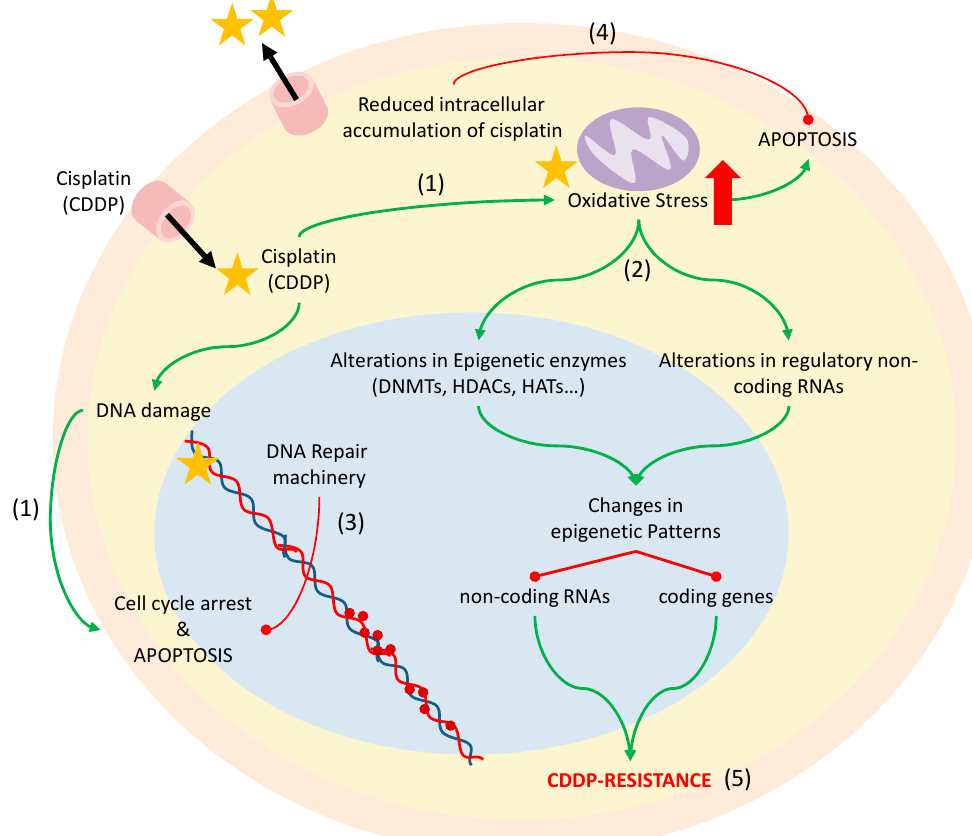
Figure 2. Effect of cisplatin inside the cell. Cisplatin is a platinum-derived drug that acts by generating aqueous species that bind to the N7 position in the guanine and causes inter and intra-strand cross-links in DNA that activate the mechanisms of cell cycle arrest or programmed cell death (1). In addition, cisplatin increases the oxidative stress of the cells, which leads to apoptosis (1), but also to alterations in the epigenetic enzymes and regulatory non-coding RNAs that change the epigenetic patterns (2). An increase of the DNA repair machinery (3), the reduced intracellular accumulation of cisplatin (4), or changes in the epigenetic machinery as a result of oxidative stress (5) lead to the development of cisplatin resistance and thus to the therapeutic limitation of its use. Red lines with rounded ends indicate inhibition. Green arrows indicate activation.